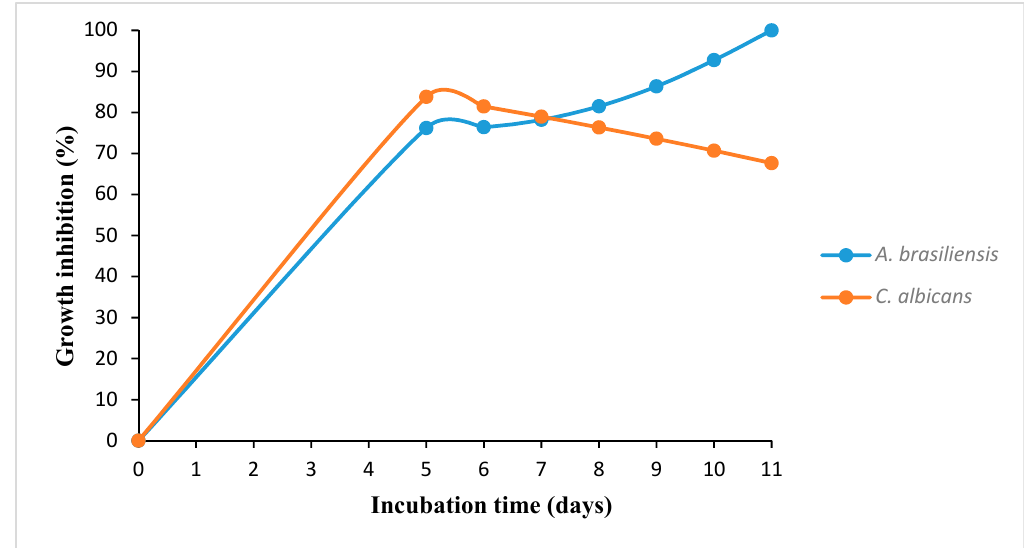
Figure 2. Growth inhibition kinetics of A. brasiliensis and C. albicans at a biosurfactant concentration of 0.99 mg/mL and temperature of 40 °C.